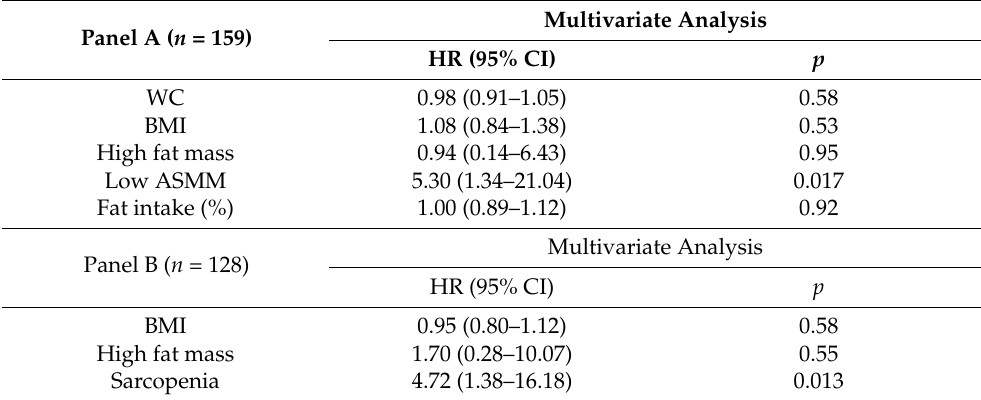
Table 3. Cox proportional hazards models for the risk of impaired fasting glucose/type 2 diabetes.